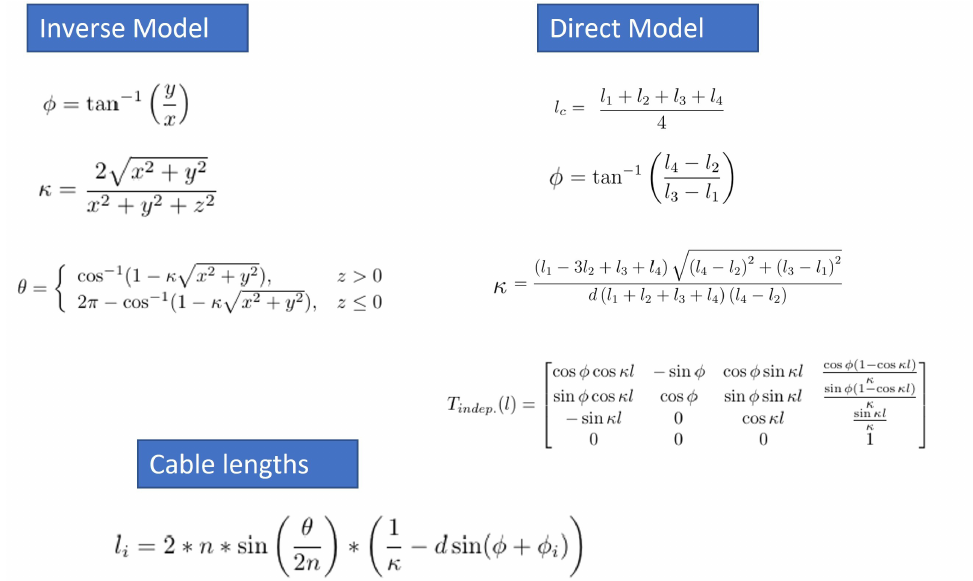
Figure 29. Equations for the Pilory robot, as deduced in Section